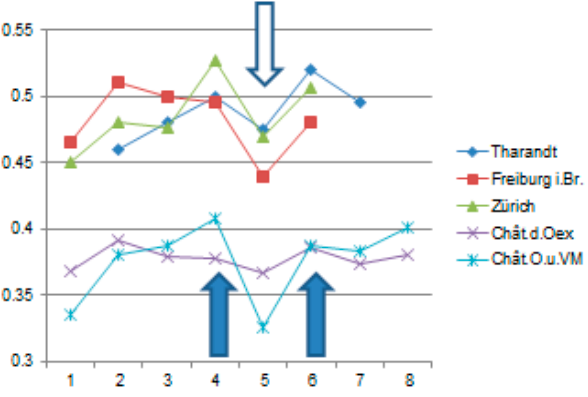
Figure 7. Variation of dry (andhydrous) densities of wood (sap- wood) of Spruce ( Picea abies ) with felling period and moon phases, according to research done in different places and years. Upper: Tharandt 1996-97 (Triebel 1998); Freiburg i.Br., 1997-98 (Seeling and Herz 1998, 2000); Zürich, 1998-99 (Bariska and Rösch 2000) / lower: Château-d’Oex 2003-04 (Zürcher et al. 2012) Means wax- ing Moon – waning, resp. Château-d’Oex 2003-04 around the Full Moon – before / after). Waxing Moon dates 1, 3, 5, 7; waning Moon dates 2, 4, 6, 8. Similar variations can be observed especially in the second half of the trial period, from December onwards (4). Reminder: most of the technological properties of wood are closely linked to its